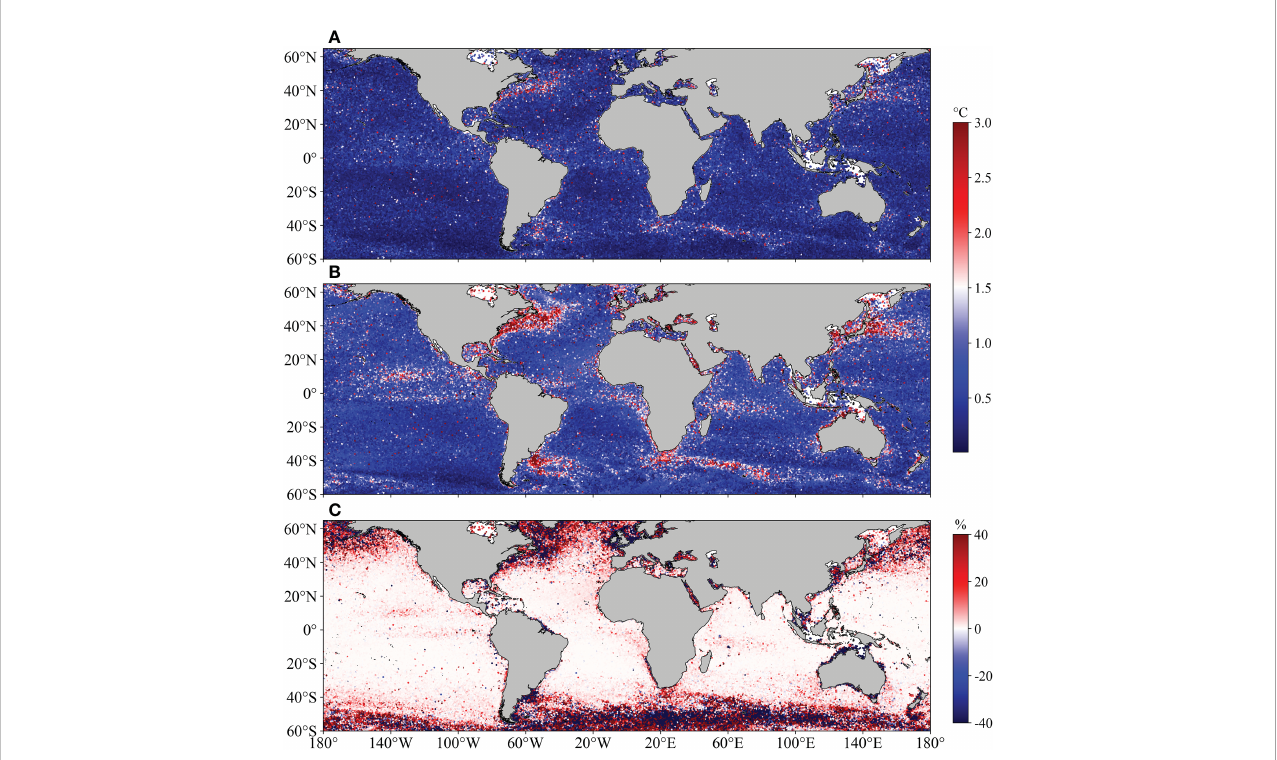
FIGURE 4 Spatial distribution of RMSE between (A) the ODF-Net, (B) EAD and EN4-pro fi les observations; (C) Spatial distribution of increase percentage in R 2 of the ODF-Net relative to